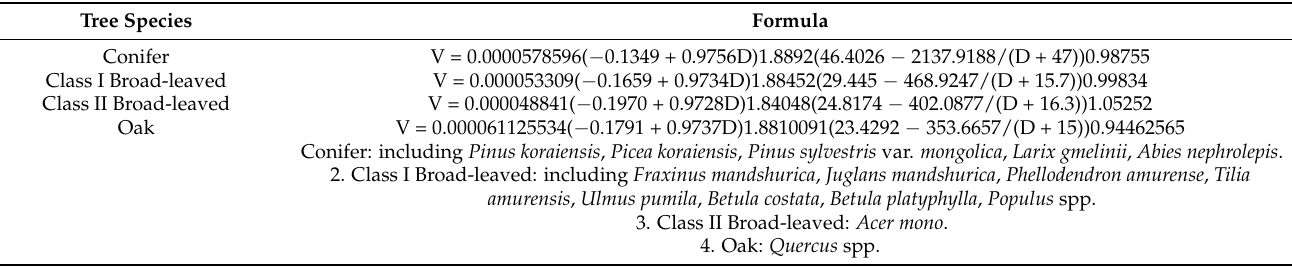
Table A1. One-Way Volume Table of Wangqing Forest